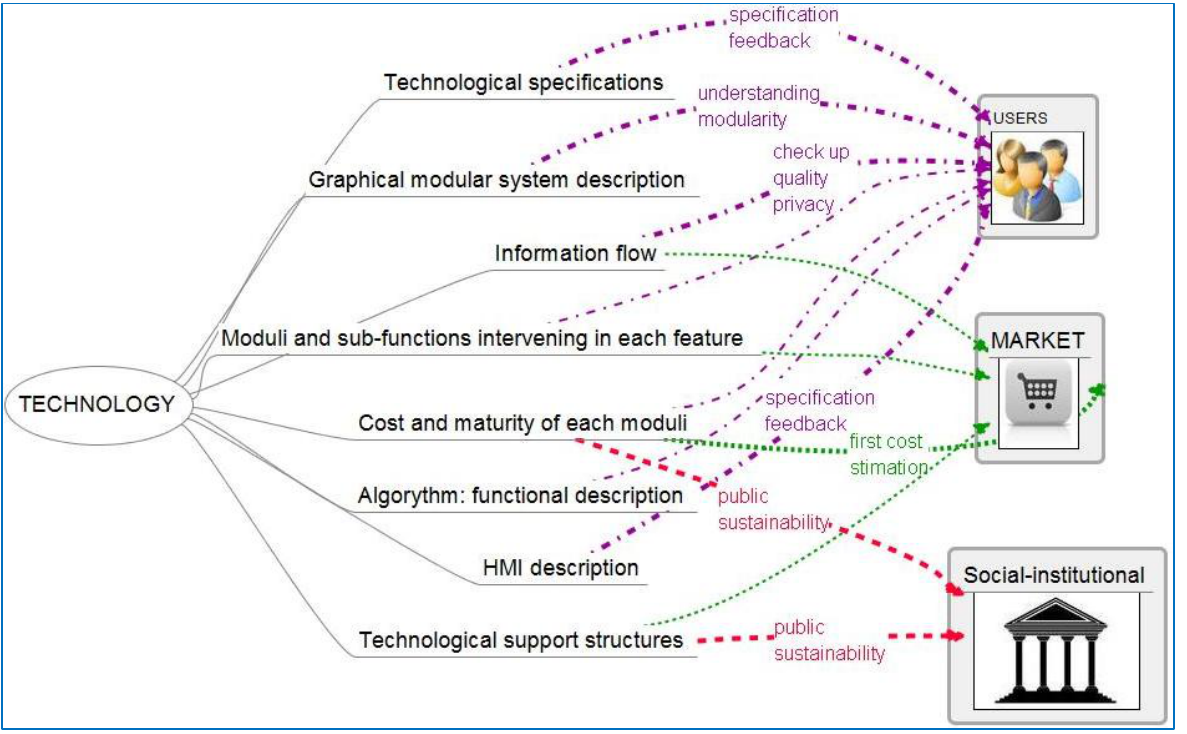
Figure 3. Cross relation of information-bits generated by technology-oriented professionals among different professional